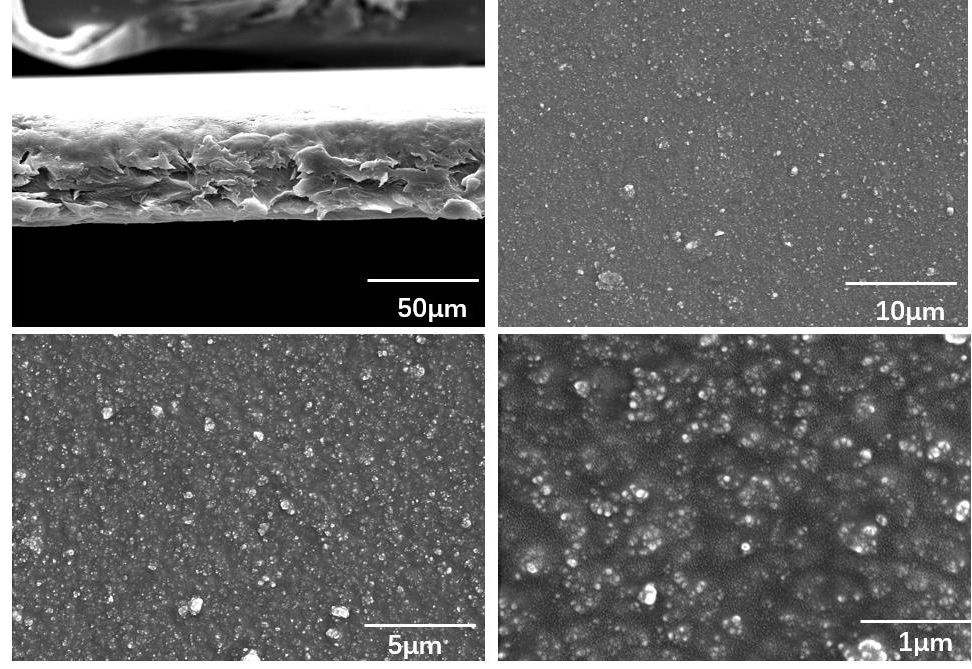
Figure 4. Cross-section SEM images of HA/PLLA composite film (20 wt%).